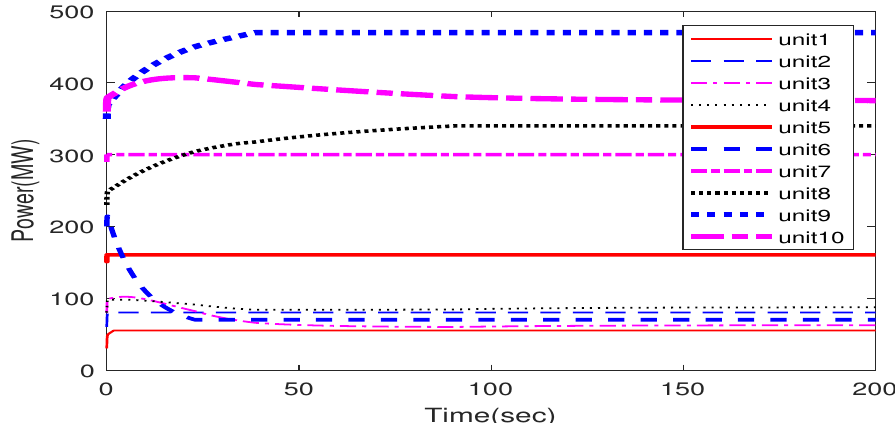
Figure 7. Output power of ten generation nodes for improved consensus protocol considering capacity